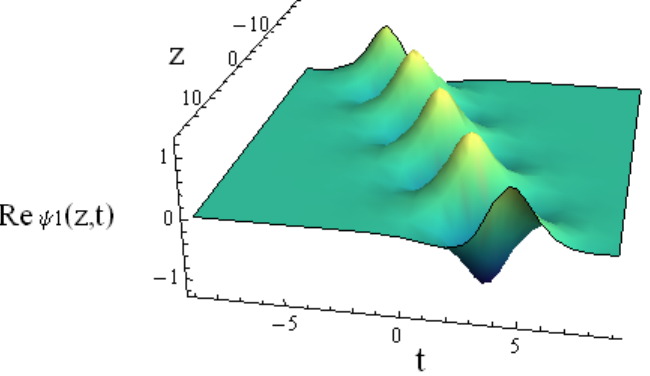
Figure 3. Change of solution (12) with z , t for c = 0.5, v = 0.7, β 1 = 0.1, β 2 = 1, β 1 = 0.1, β 3 = 0.3, β 4 = 0.2.